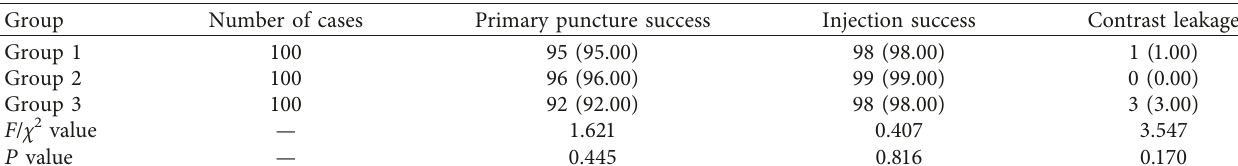
Table 2: Comparison of primary puncture success rate, injection success rate, and contrast leakage rate among the three groups of patients ( n ,